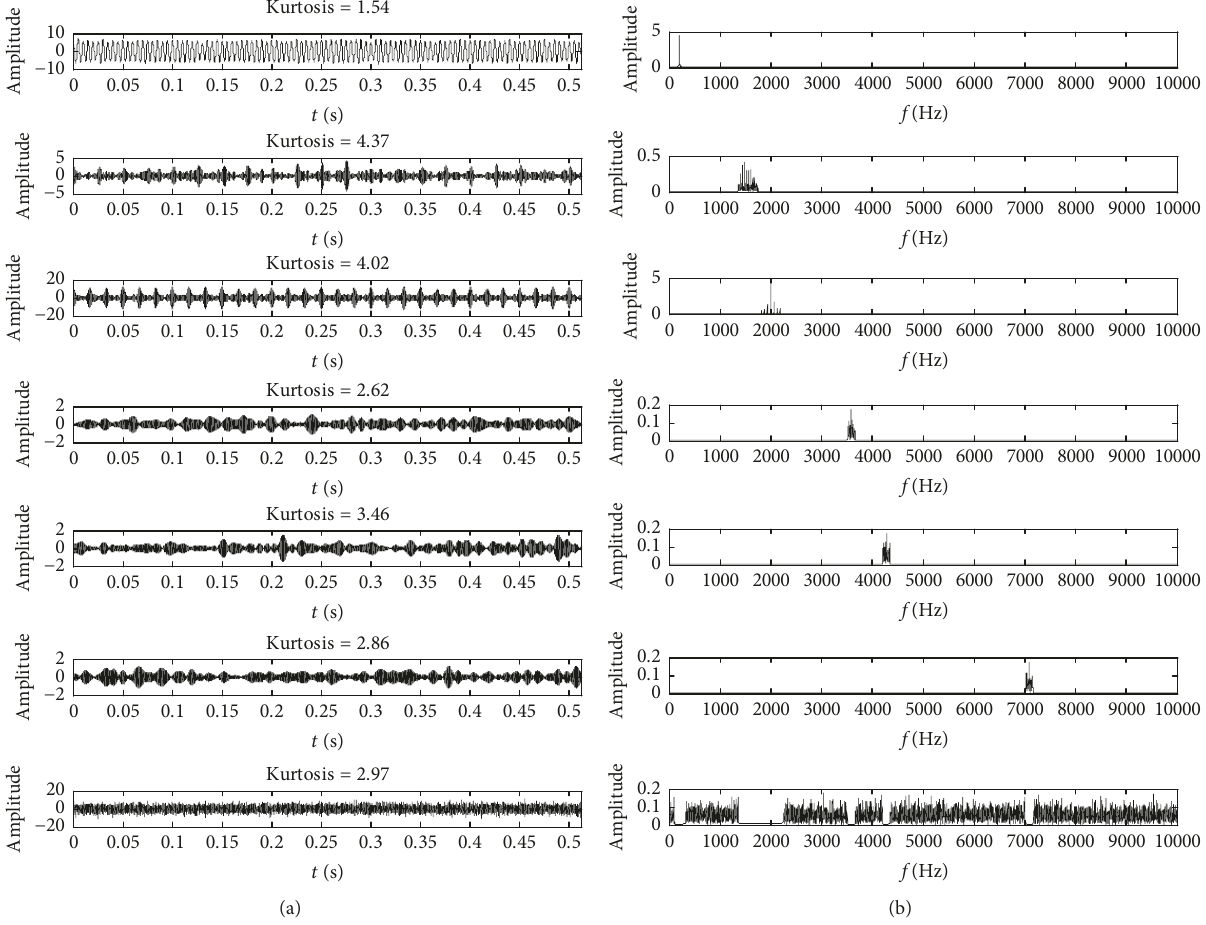
Figure 12: The result of the proposed method for the signal when SNR is − 10. (a) is bandpass filtering signals, and the bottom of (a) is the surplus signal. (b) is the spectrum of corresponding (a).